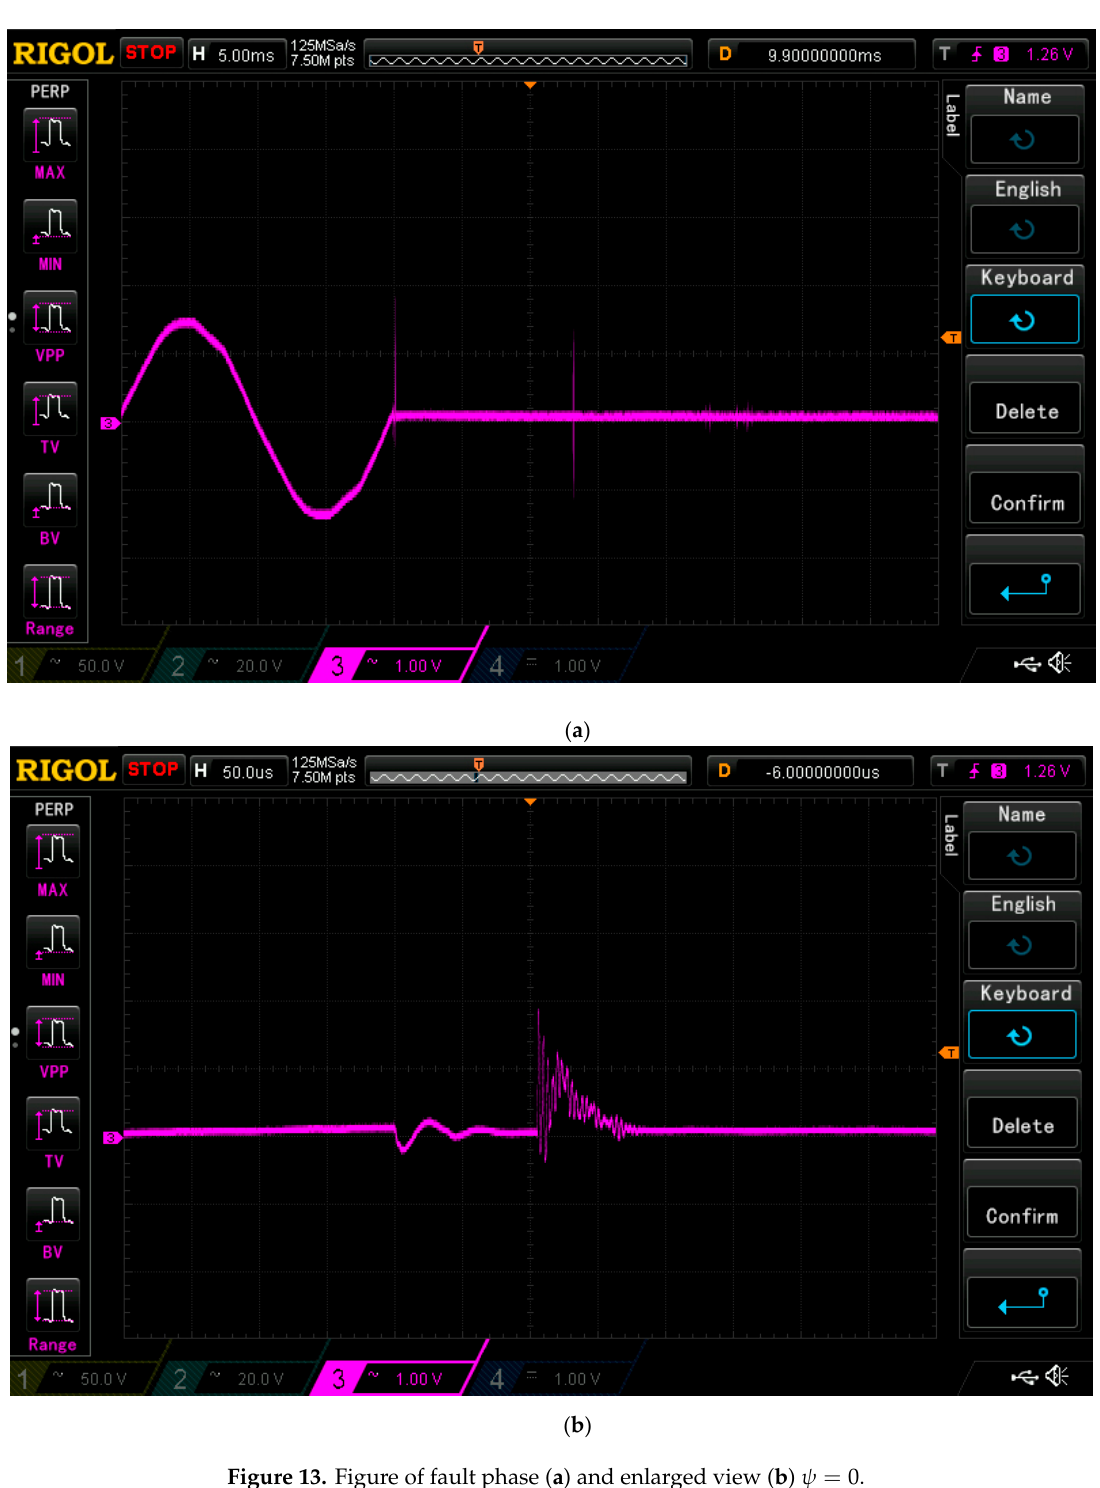
Figure 13. Figure of fault phase ( a ) and enlarged view ( b ) . ψ =